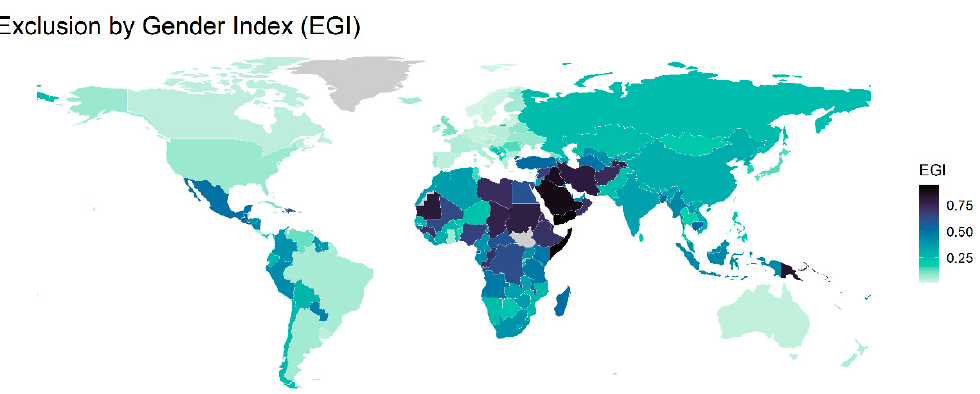
Figure 2. Exclusion by Gender Index by country. Dark blue indicates more gender-inegalitarian countries, and light green indicates more gender-egalitarian countries. Source: V-DEM data for the year 2018.